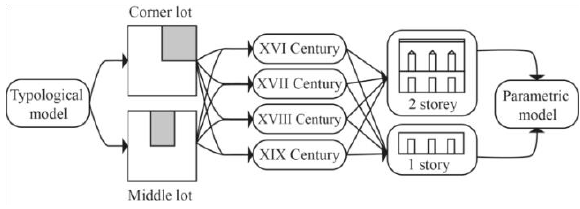
Figure 5. Workflow to determine a parametric model from typological features.